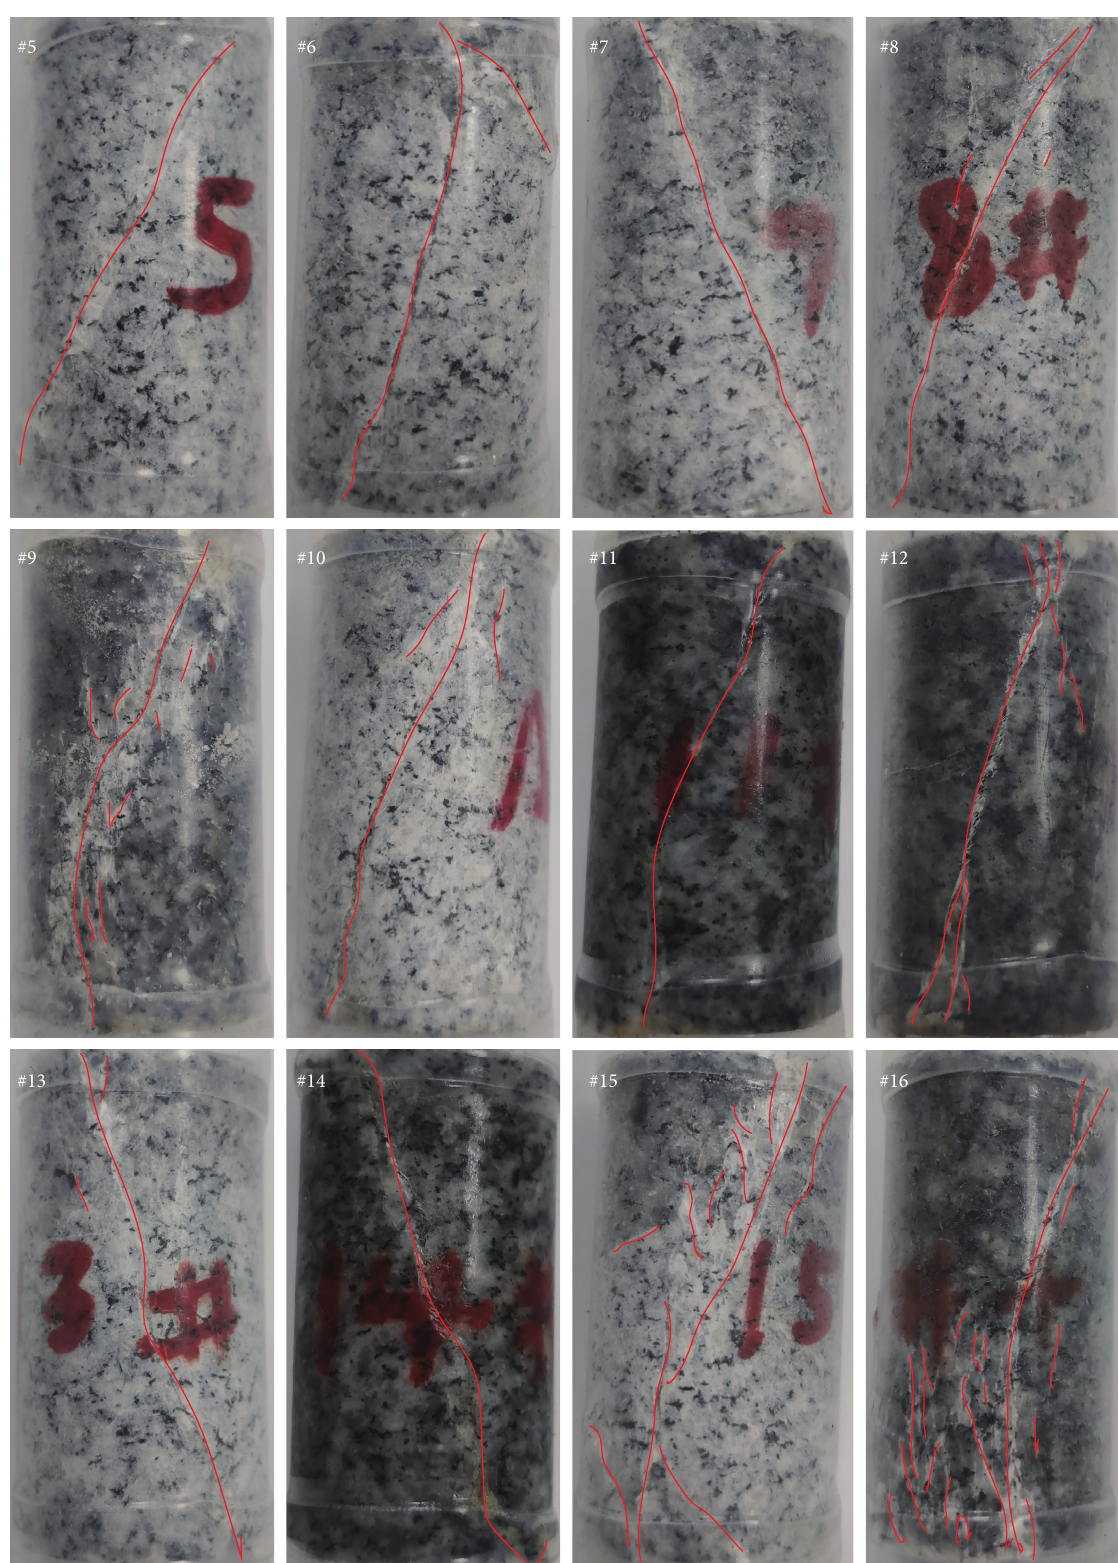
Figure 5: Postfailure images of tested granite specimens. From left to right, the experimental temperature conditions are 60 ° C, 90 ° C, 120 ° C, and 150 ° C. From top to bottom, the fluid injection conditions are dry, water, and CO 2 . The red lines show the fractures on the surface of tested